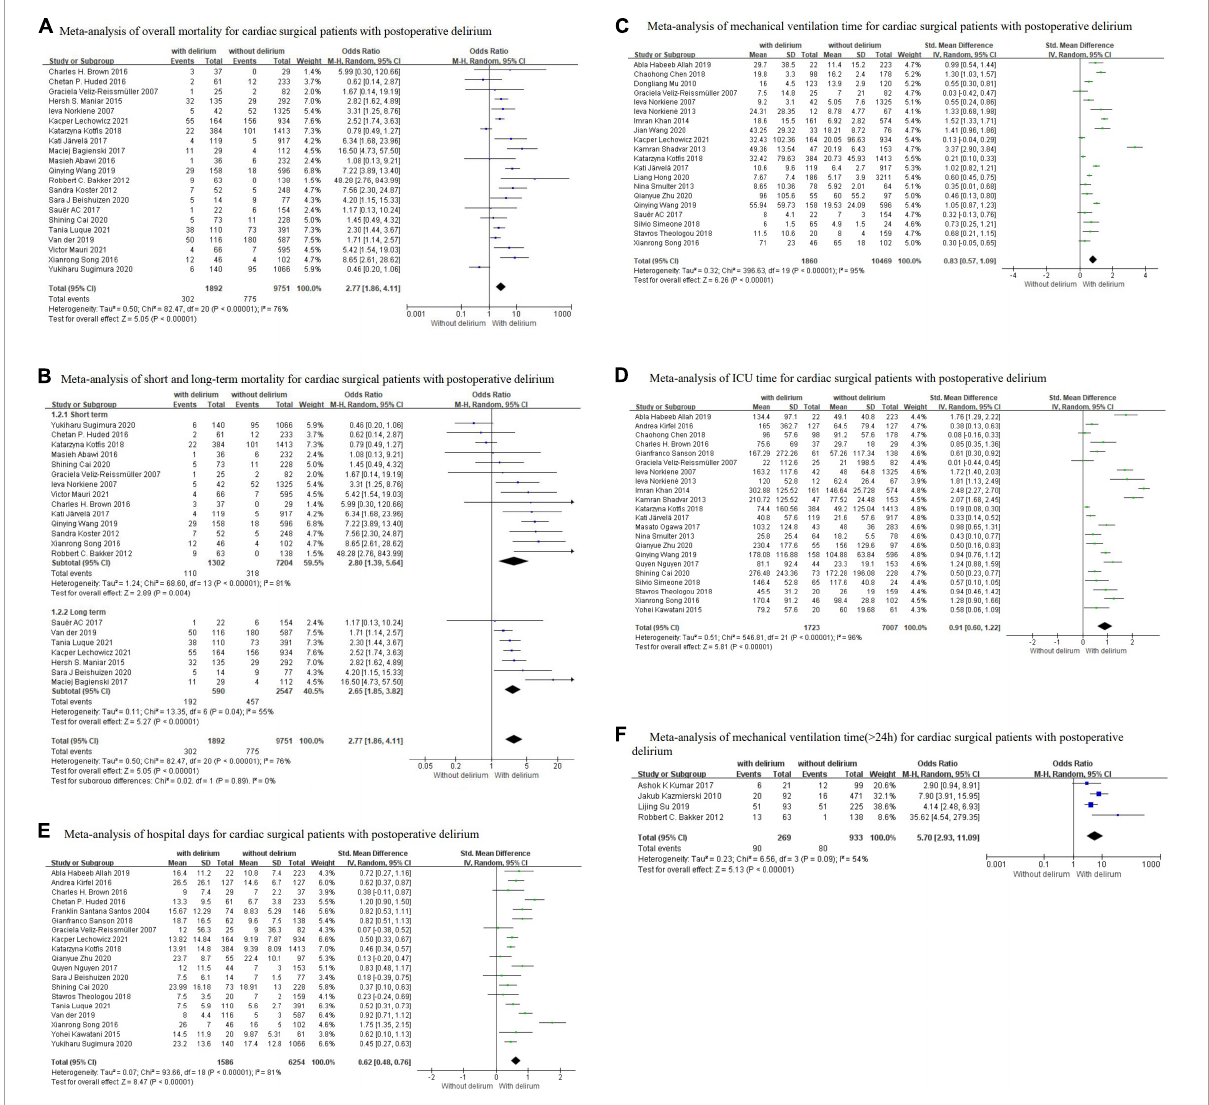
FIGURE2 Results of meta-analysis on the association between postoperative delirium and outcomes (A) Overall mortality; (B) Short-term and long-term mortality; (C) Mechanical ventilation time; (D) ICU time; (E) Hospital days; (F) Prolonged mechanical ventilation time ( > 24h). The summary effects were obtained using a random-effects model. The size of the data markers indicates the weight of the study. The diamond data markers indicate pooled ORs or SMD, and 95%